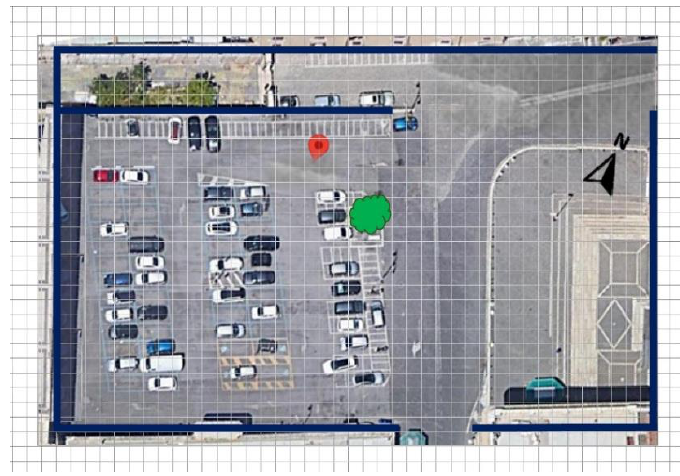
Figure 2. ENVI-Met model of St. Peter in Chains’ square with grid and boundaries.